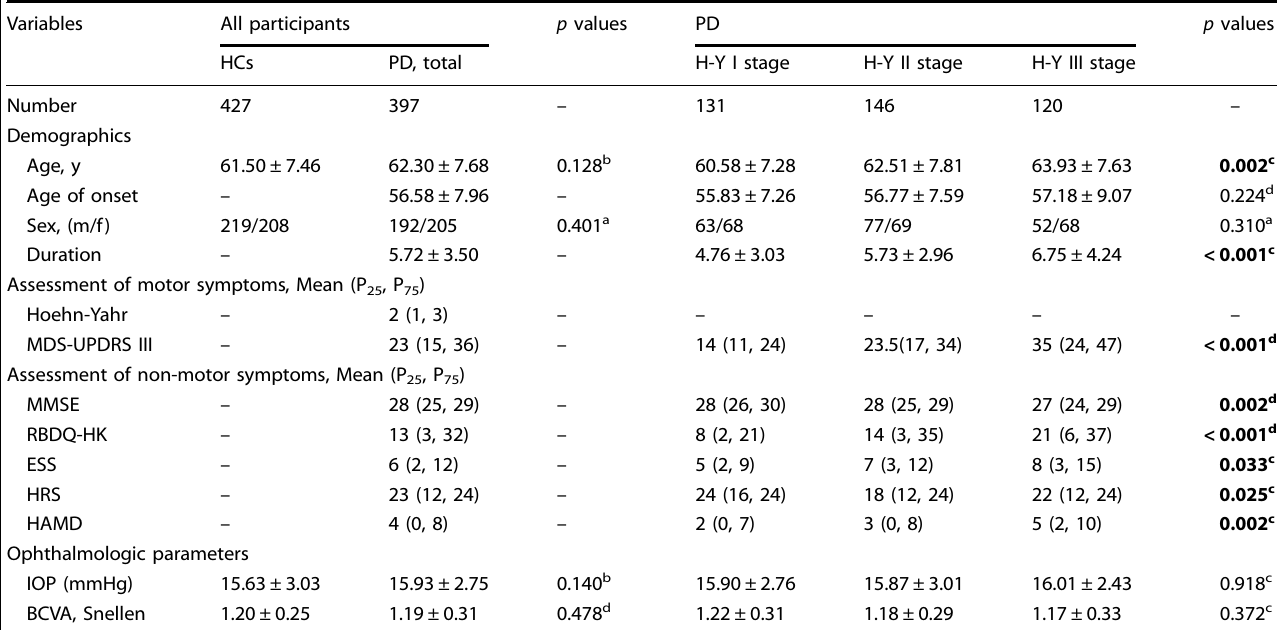
Table 1. Clinical and general demographics characteristics of all the participants.